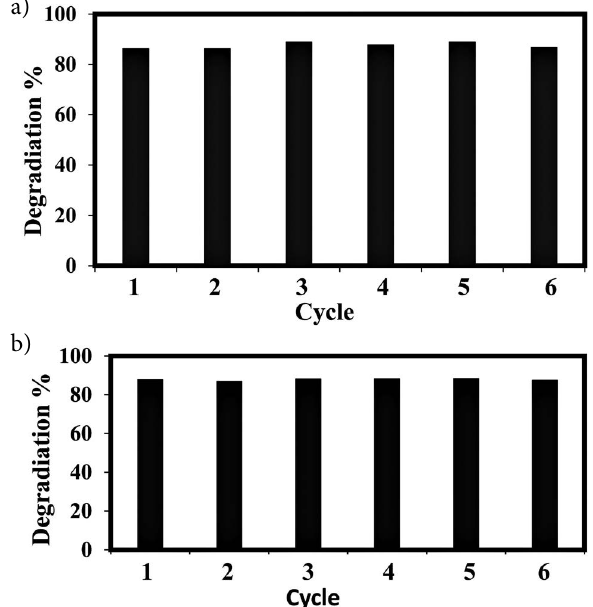
Fig 12. Recyclability and reusability of the synthesized Ag/HNTs for the reduction of Rh6G and